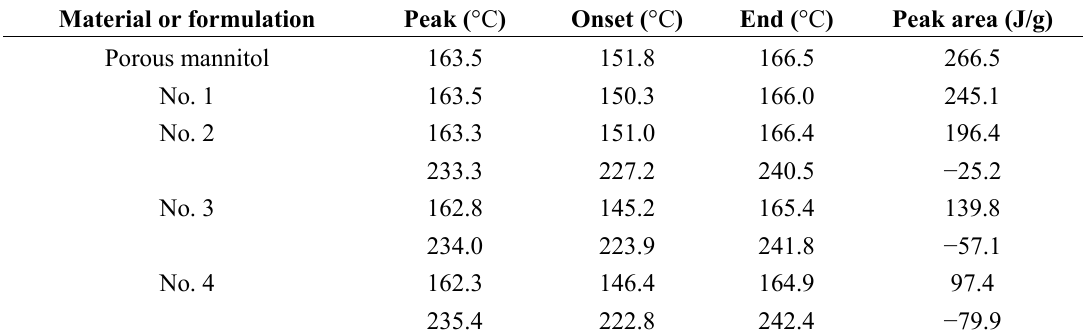
Table 3. Differential scanning calorimeter data of porous mannitol, LEV-proliposome formulations and